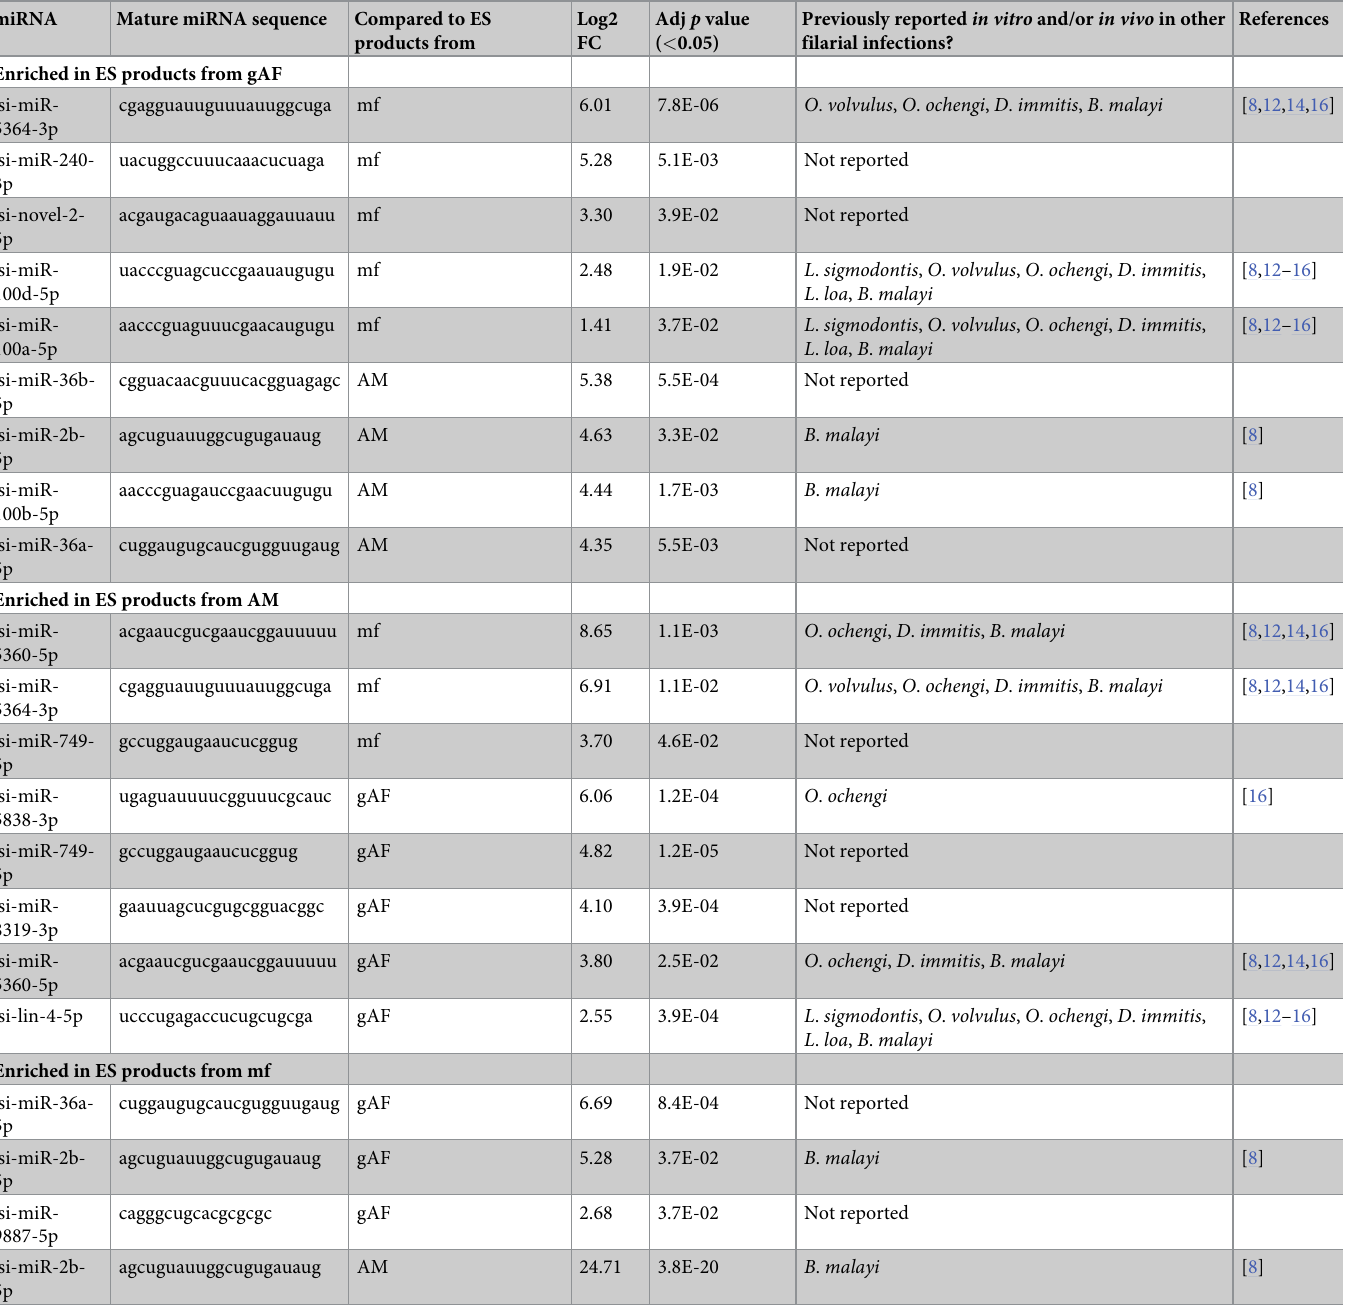
Table 3. Differentially expressed miRNAs in the ES products of larval and adult stages of L . sigmodontis . miRNA Mature miRNA sequence Compared to ES